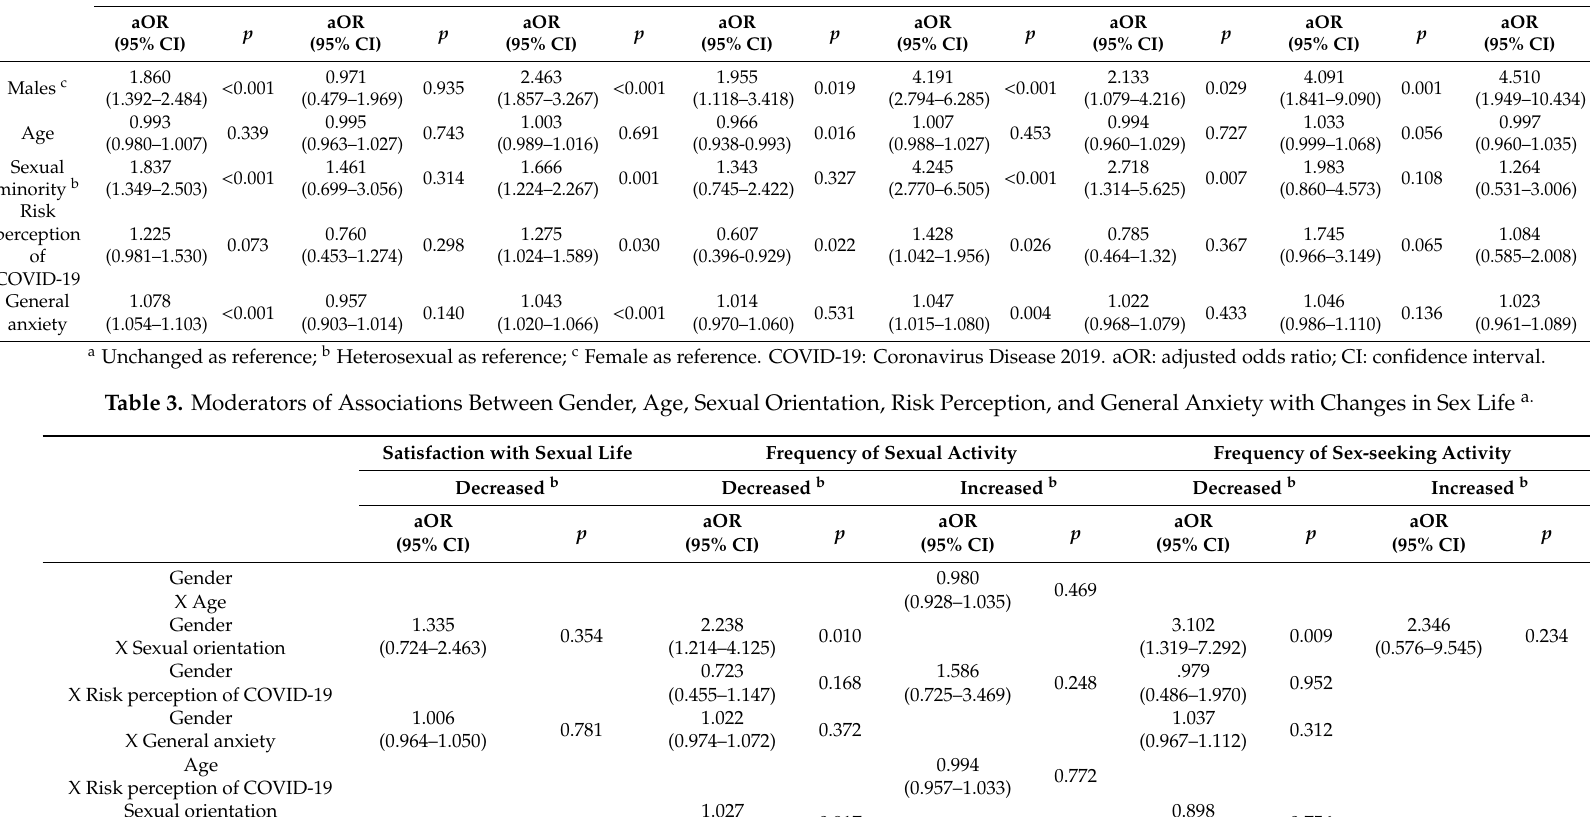
Table 2. Associations of Gender, Age, Sexual Orientation, Risk Perception of COVID-19, and General Anxiety with Changes in Sex Life. Satisfaction with Sexual Life Frequency of Sexual Activity Frequency of Sex-seeking Activity Frequency of Protection for Sex Decreased a Increased a Decreased a Increased a Decreased a Increased a Decreased a Increased a